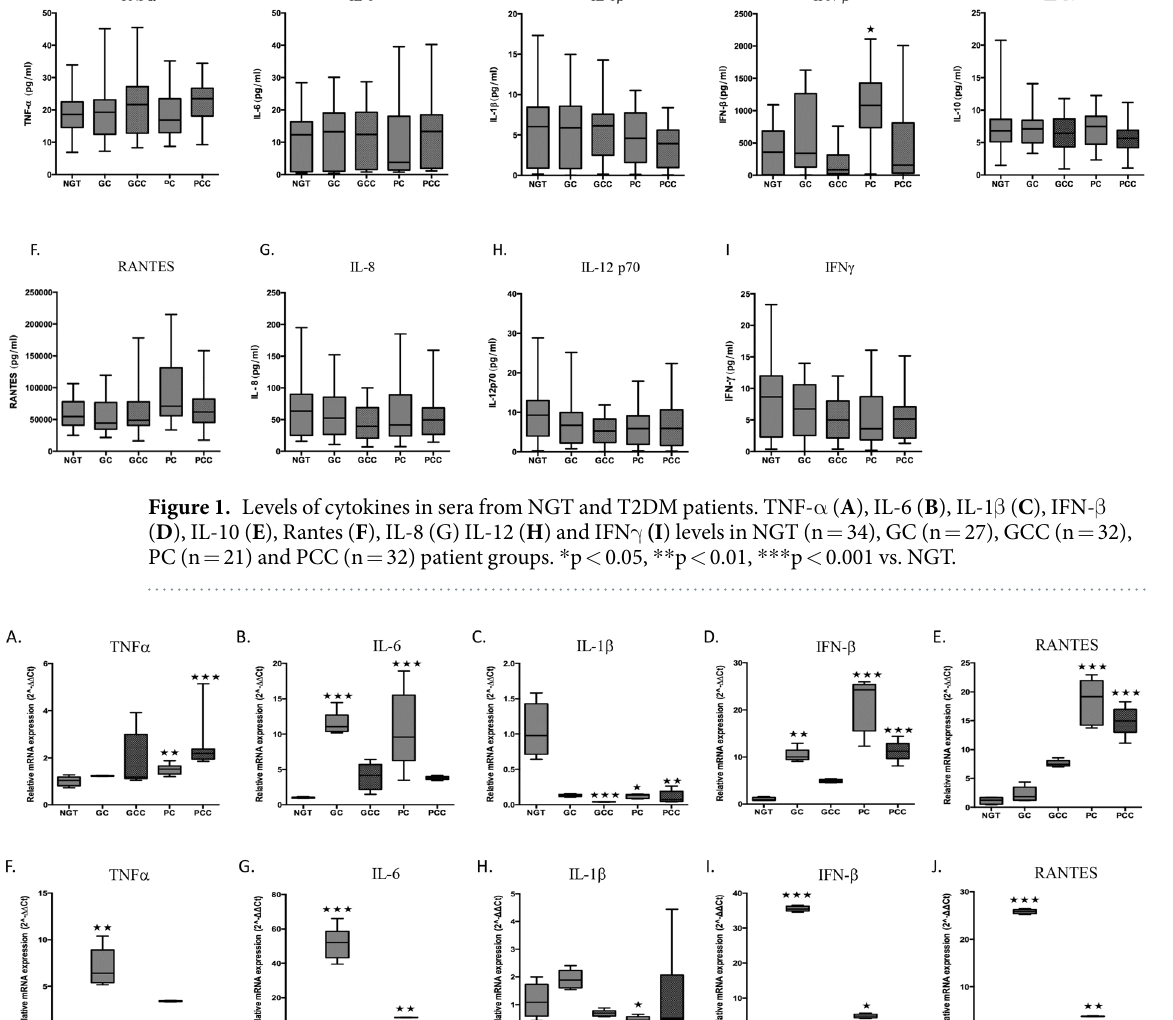
Gene expression of TNF α , IL-6, IL-1 β , IFN- β and Rantes in monocytes and neutrophils from NGT and T2DM patients. The transcriptional regulation of cytokines involved in regulating the inflamma-